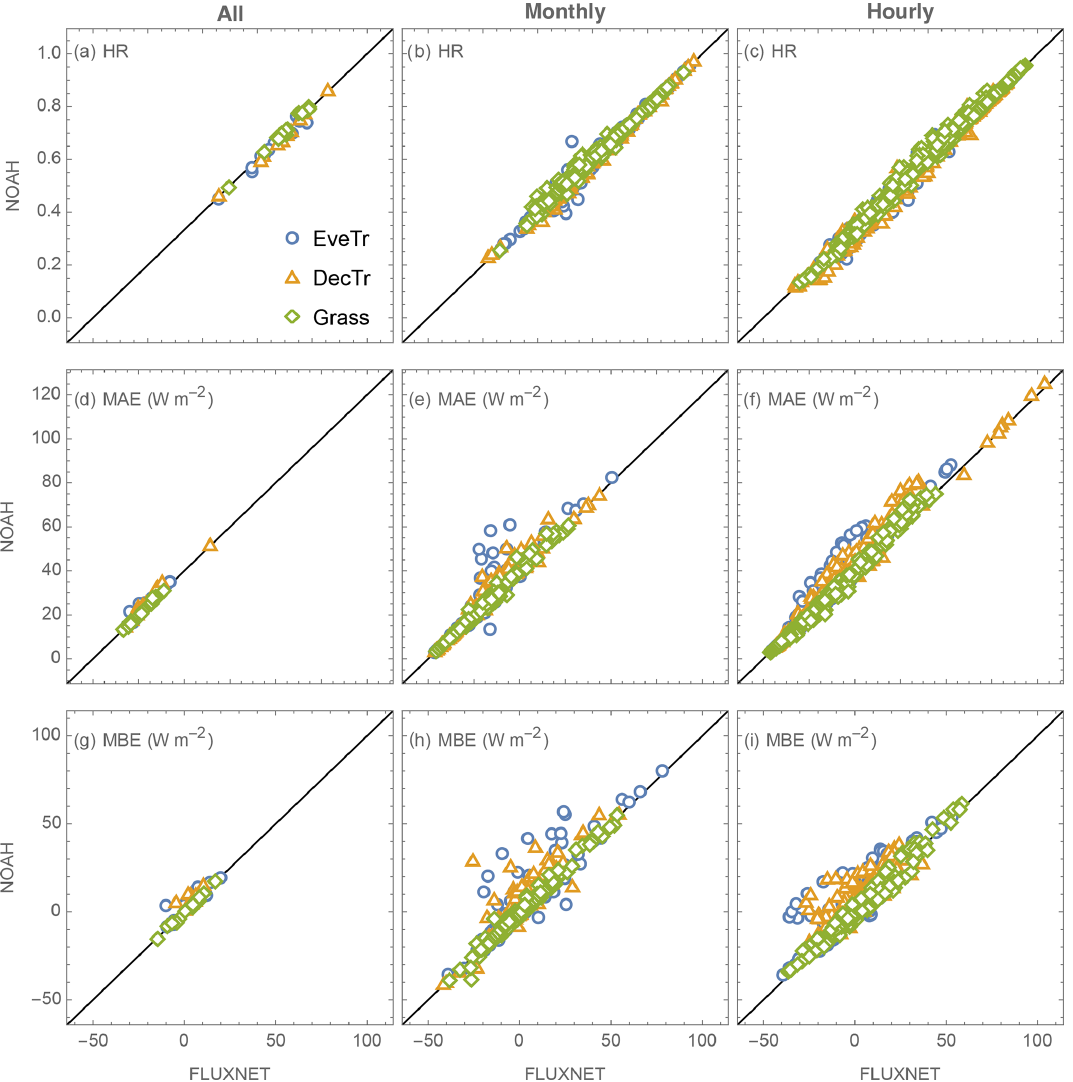
Figure 15. Relation between NOAH and FLUXNET of (rows) three evaluation metrics for (columns) three temporal scales (all, n = 38 sites but different number of samples per site, Table 3; monthly, n = 456 = 38 sites × 12 months; and hourly, n = 912 = 38 sites × 24h). Data points are colour coded by land cover